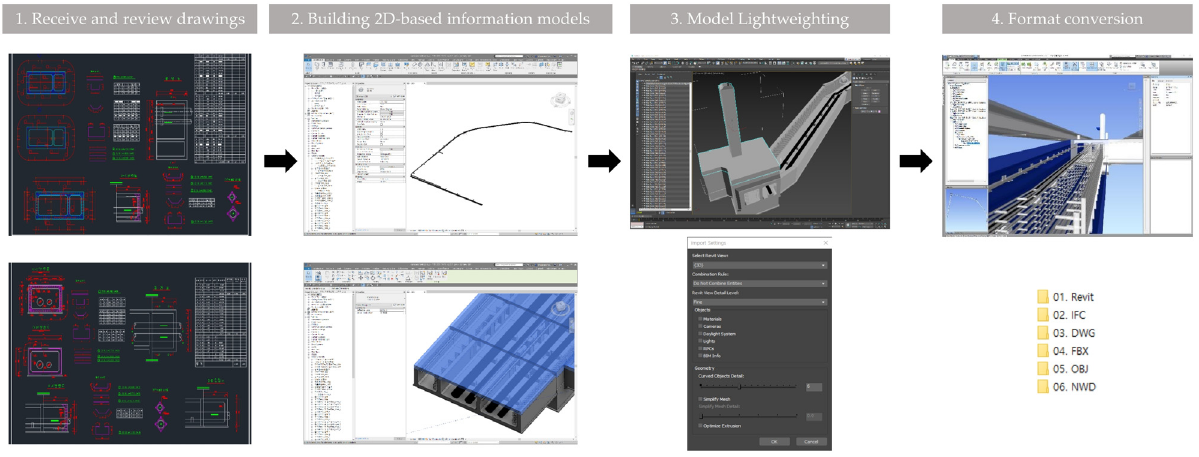
Figure 3. BIM model building procedure based on design drawings.